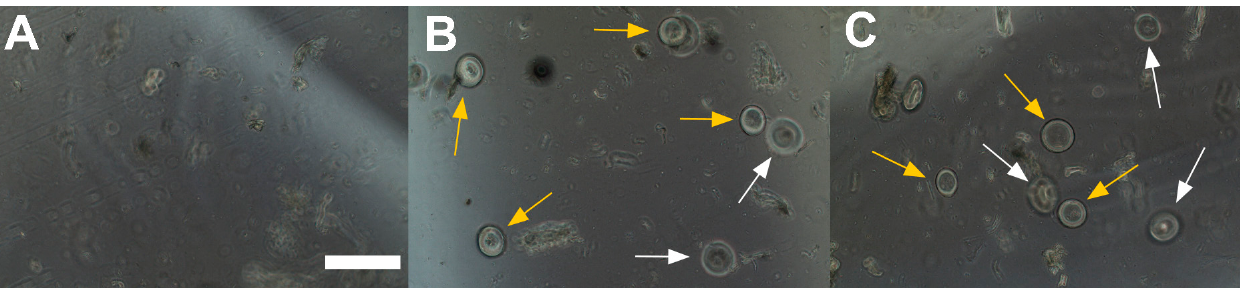
Figure 8. Distribution of microspheres in BIEGM ( B ) and BITGM ( C ) scaffolds compared to the bare scaffold produced using BI ( A ), showing focused (orange arrow) and unfocused (white arrow) microspheres. The scale bar represents 500 μ m.